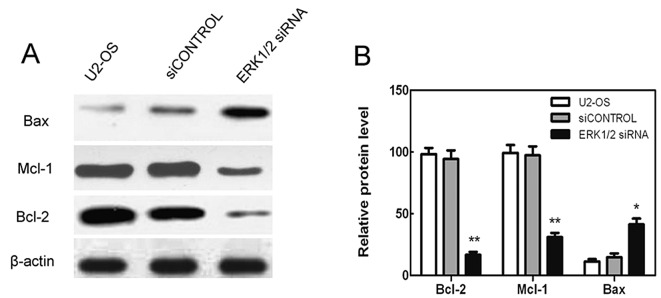
Inhibition of ERK1/2 decreases expression of Bcl-2 and Mcl-1, whereas it induces Bax expression in U2-OS cells. The cells were treated with indicated siRNAs for 48 h, and 30 μg cell lysate proteins were separated on 10% sodium dodecyl sulfate-polyacrylamide gel electrophoresis and detected using specific antibodies. Immunoblotting of actin was shown to demonstrate loading equivalency. Inhibition of ERK1/2 significantly reduced expression of Bcl-2 and Mcl-1, whereas it induced Bax expression in U2-OS cells (A). The columns represent the ratio of Bcl-2, Mcl-1 and Bax to actin (B). Data represent the mean ± SD of three independent experiments. *P<0.05 and **P<0.01 vs. siCONTROL.